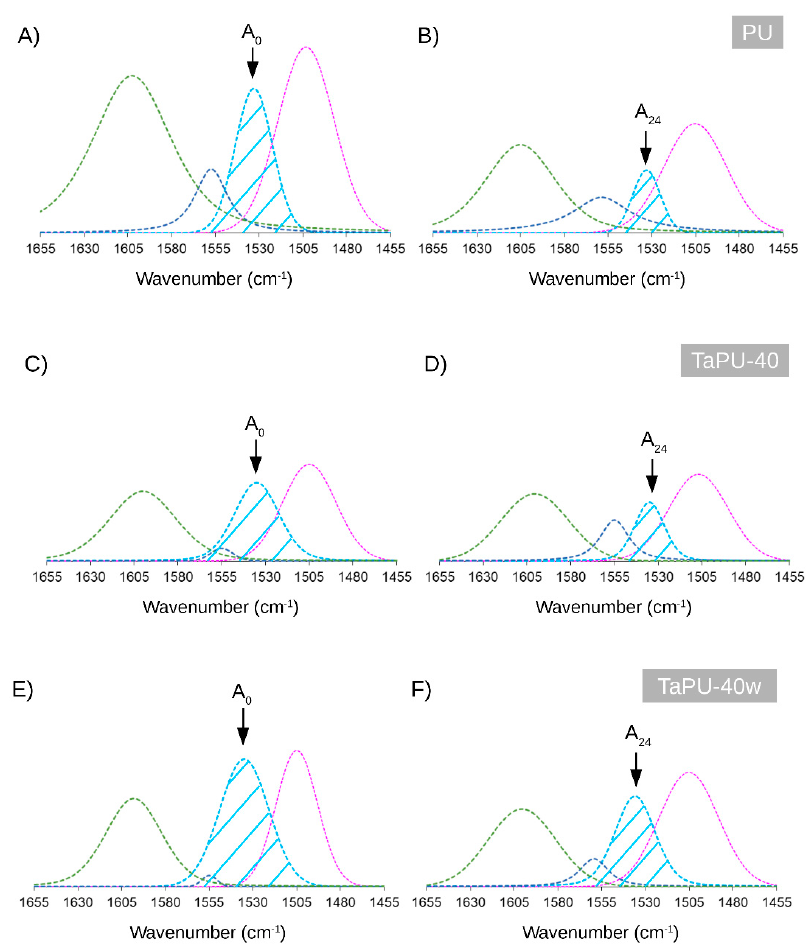
Figure 8. Deconvoluted spectra of PU, TaPU-40, and TaPU-40w before and after UV exposure for 24 h: ( A , C , E ) before UV treatment; ( B , D , F ) after UV treatment.